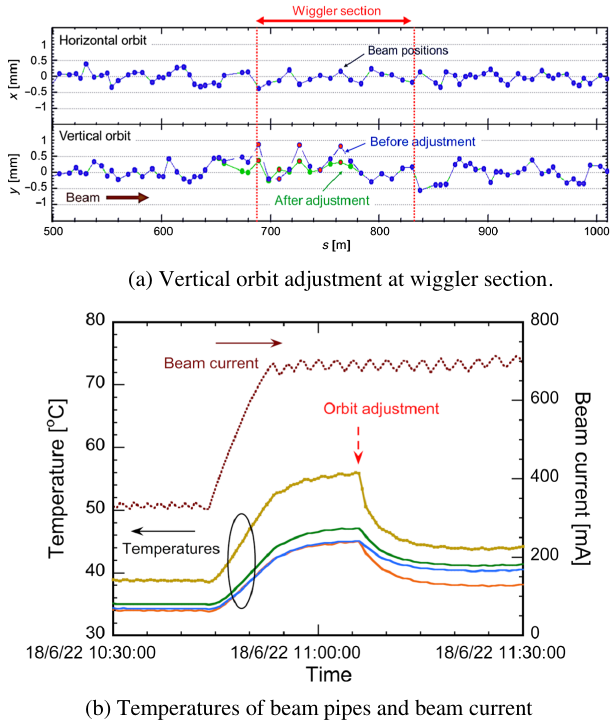
FIG. 29. (a) Adjustment of the vertical orbit at a wiggler section, where blue dots are the horizontal and vertical positions of the beam measured by beam position monitors placed almost every 10 m. The vertical orbit was adjusted from the dashed blue line to the green line by correction magnets. (b) Change in temperatures of several beam pipes in the wiggler section at the timing of the vertical orbit adjustment shown in